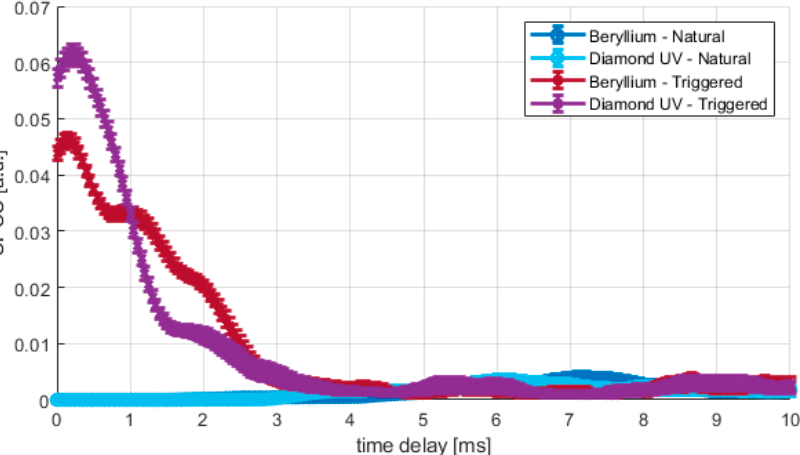
Figure 10. Average SPCC profile of natural and triggered ELMs for shot 92238 using beryllium line and diamond UV diagnostics.